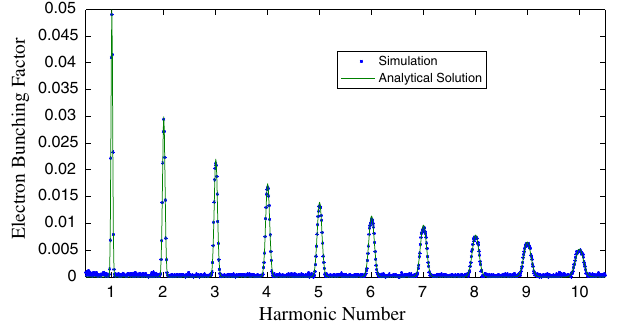
FIG. 2. Electron bunching factor for a Gaussian seed laser pulse with quadratic phase. The seed laser pulse has phase (cid:2) , amplitude A (cid:3) ð (cid:5) ¼ 30 (cid:5) p , and rms bandwidth k Þ ¼ 0 (cid:5) =k k L ¼ 10% . Amplitude of the bunching factor is small due to averaging over a long electron bunch of uniform length L ¼ 10 (cid:5) L [Eq. (5)]. Simulated bandwidths (blue) reproduce the analytical result [Eq. (12) in green, scaled to match the bunching amplitude]. As expected, the peaks broaden at higher